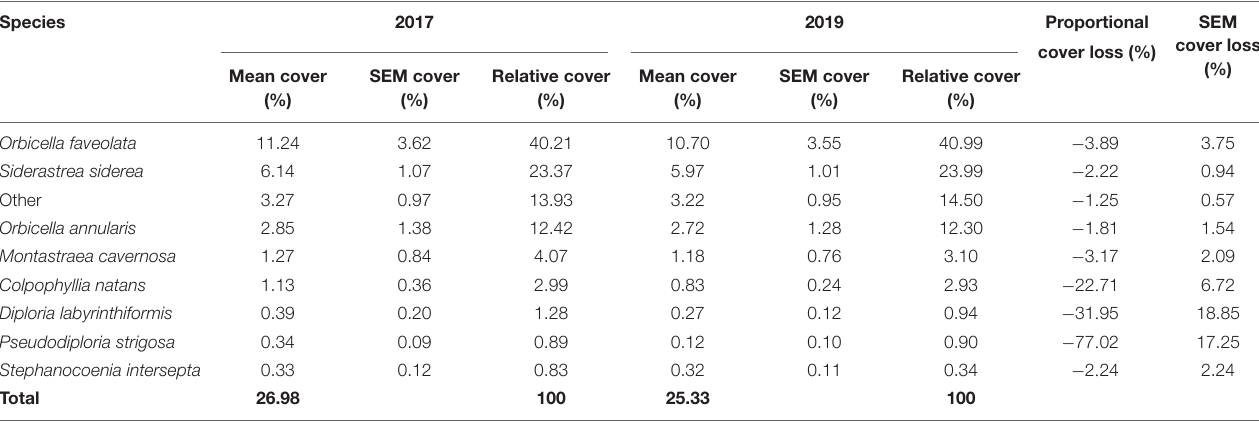
FIGURE 3 | Proportion of complete mortality, partial mortality, and loss of coral cover for the eight most abundant, SCTLD-susceptible species across the photomosaic plots. Error bars represent standard error of the mean. Test results are from separate single-factor Kruskal-Wallis tests, and different letters denote significant Dunn’s pairwise comparisons between species pairs for each metric. Species ordered from left to right according to decreasing absolute percent cover. TABLE 3 | Mean absolute and relative percent cover across all six plots from 2017 to